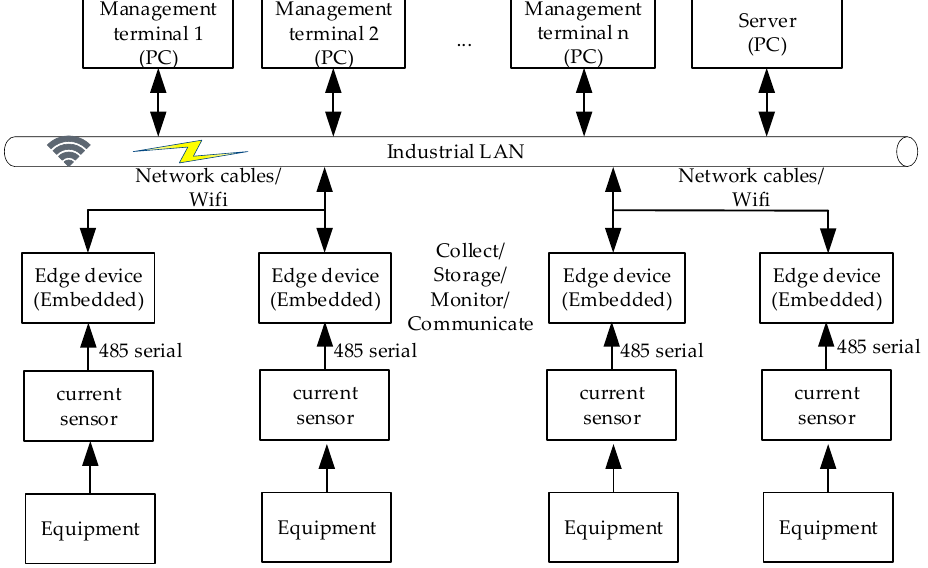
Figure 1. Block diagram of the overall composition of the equipment production status monitoring system consisting of current sensor, edge device, management terminal, and server.